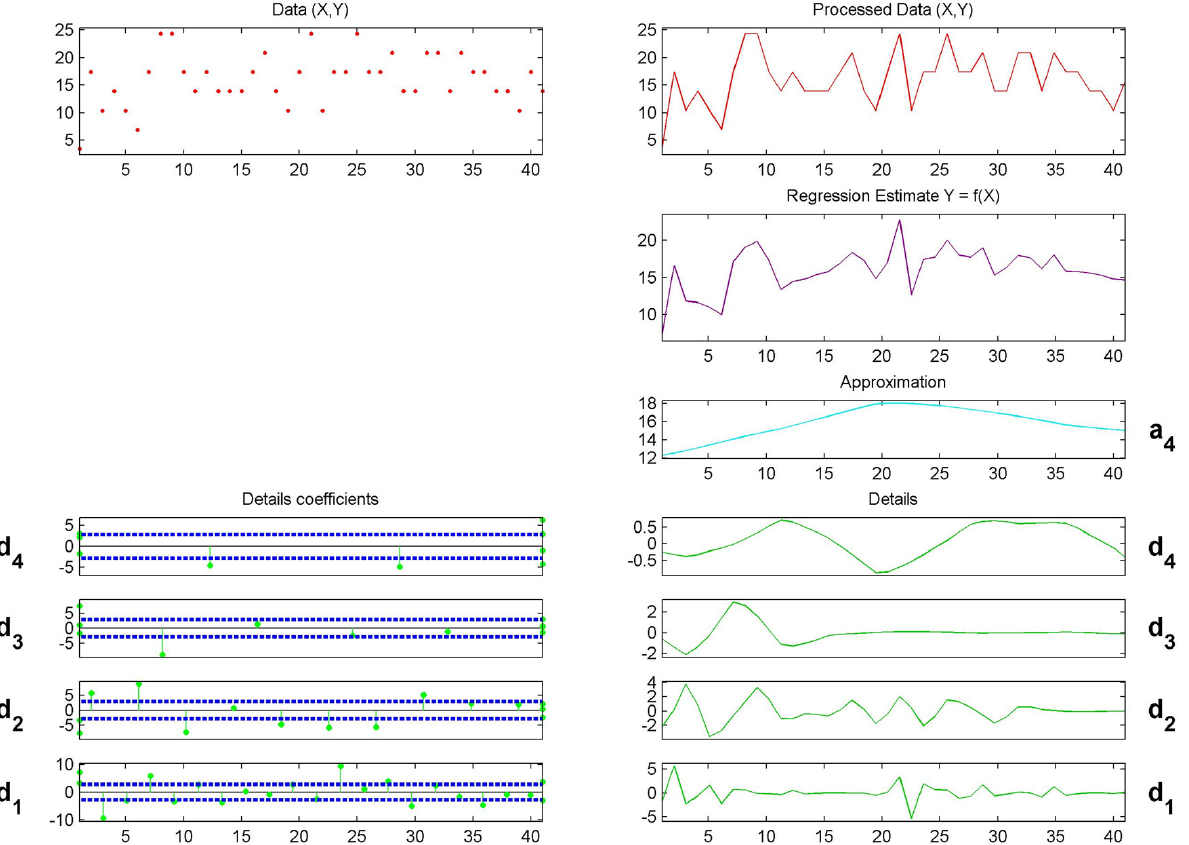
Figure 11. Details of coefficients of the flow rate time series in the Wavelet algorithm. The d 1 d 2 , d 3 and d 4 are the Wavelet coefficients.